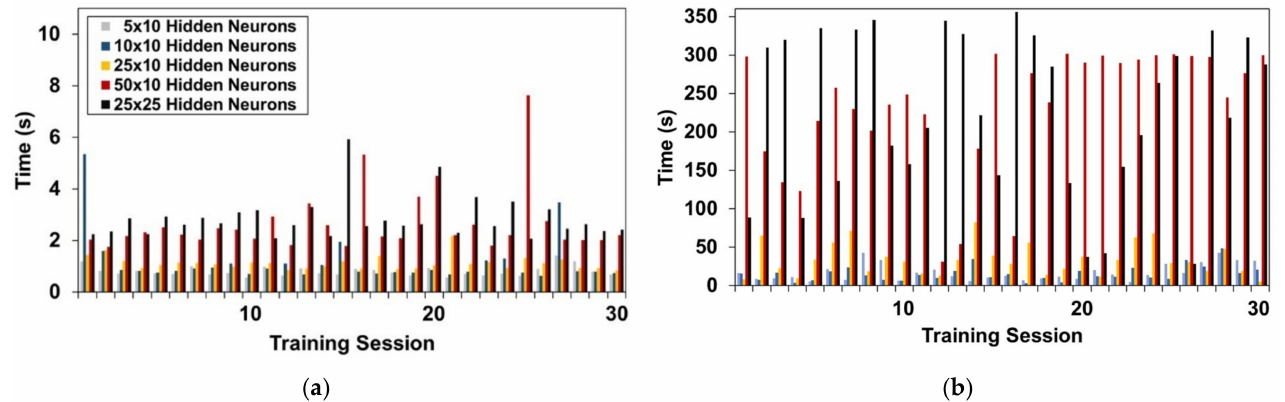
Figure 15. Duration of each training session of FFNN2 with two hidden layers for: ( a ) LM training algorithm; ( b ) BR training algorithm.